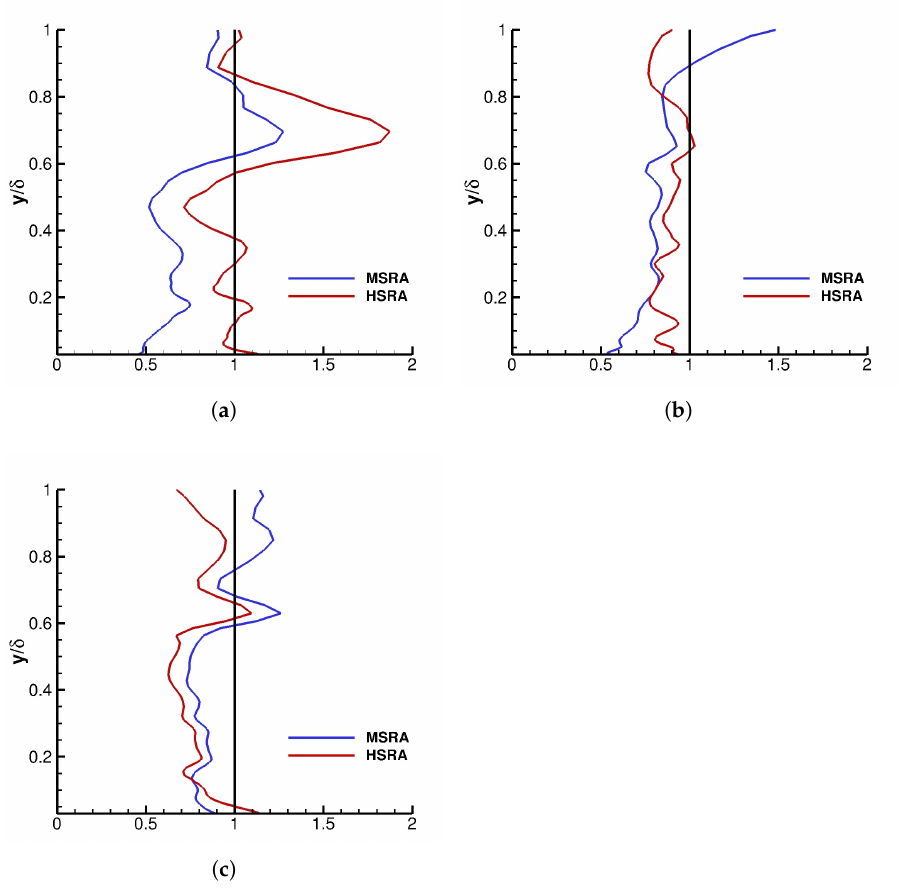
Figure 12. Strong Reynolds Analogy for: ( a ) T w / T aw = 0.54. ( b ) T w / T aw = 0.79. ( c ) T w / T aw = 1.0. Figure 13 shows the calculated turbulent Prandtl number (Equation (46)) for the three wall temperatures. The black line represents the constant turbulent Prandtl number